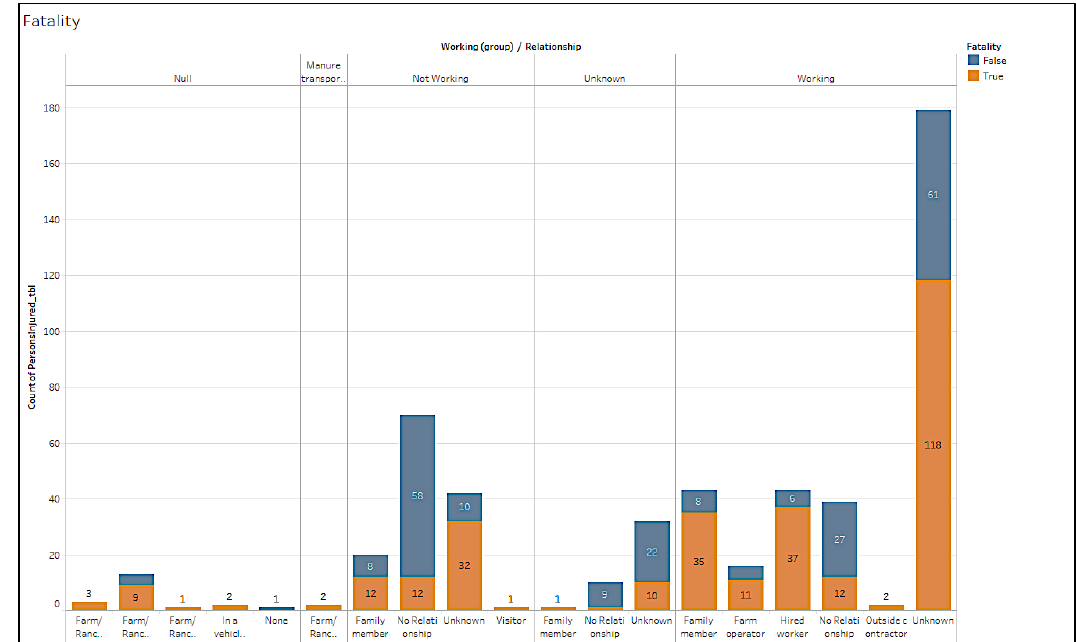
Figure 7. Dashboard software display map with case count.